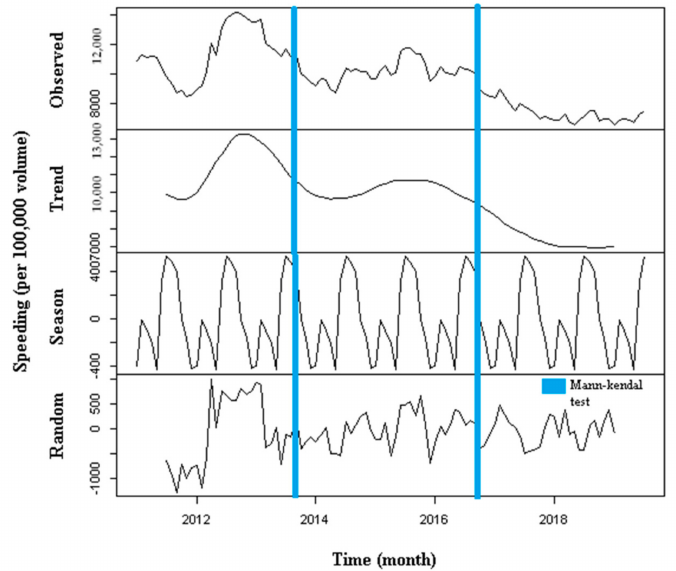
Figure 3. Decomposing the additive time series on a monthly basis for speeding per 100,000 vehicles in Iran, with blue vertical lines showing the points analyzed with a Mann-Kendall Test, from March 2011 to October